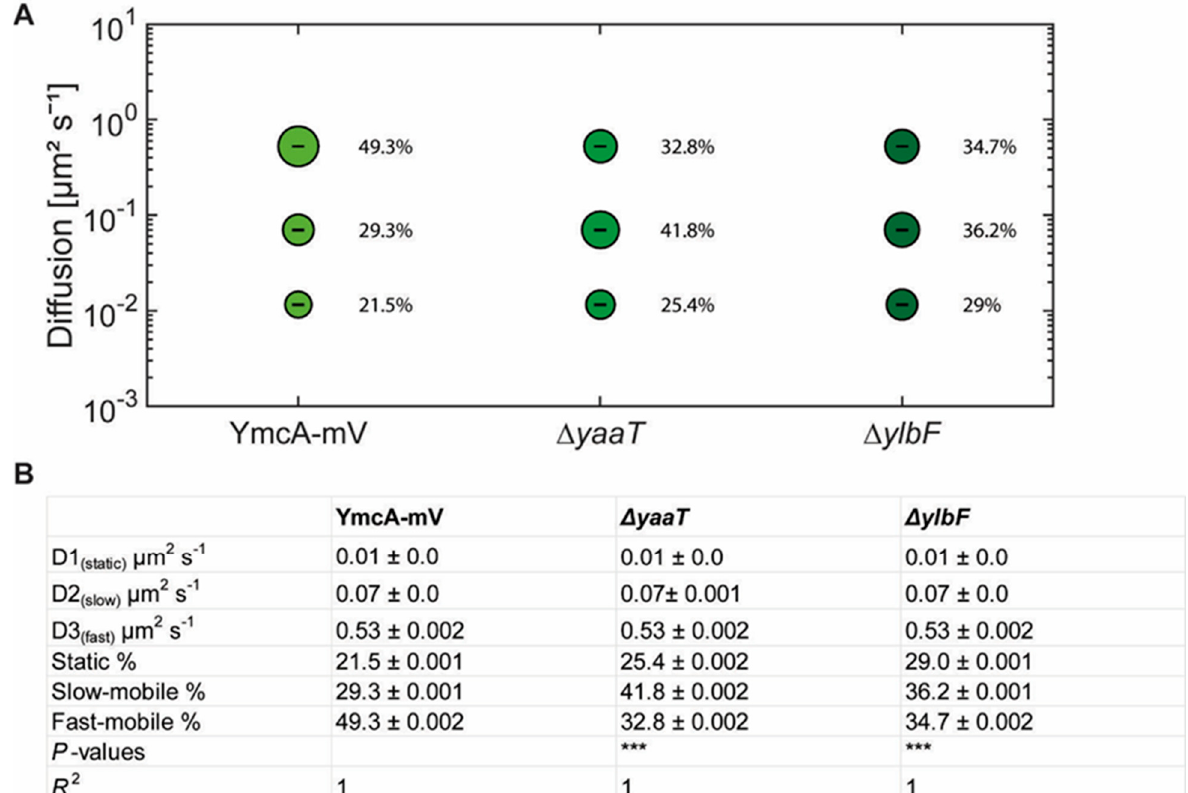
Figure 7. ( A ) Bubble blots showing squared displacement analysis of YmcA-mV under different conditions in cells grown to mid-exponential phase. Bubble blot shows diffusion constants [ µ m 2 s − 1 ] of YmcA-mV, YmcA-mV ∆ yaaT and YmcA-mV ∆ ylbF cells and comparison of fast-mobile, slow-mobile and static fraction sizes [%]. ( B ) Diffusion constants and percentages of static, slow-mobile and fast-mobile molecule fractions. p- value: The symbol *** represent p -values lower than or 0.001.